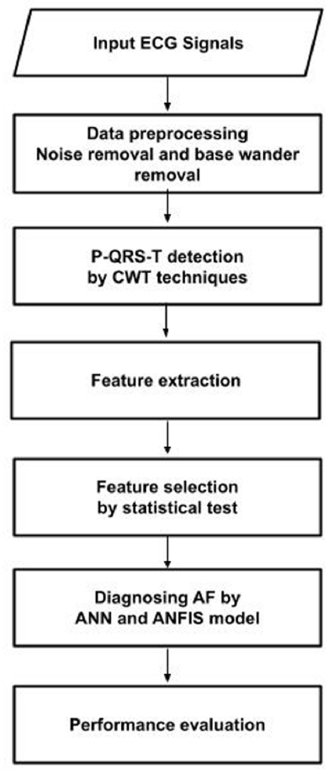
Figure 2. Research flow diagram.